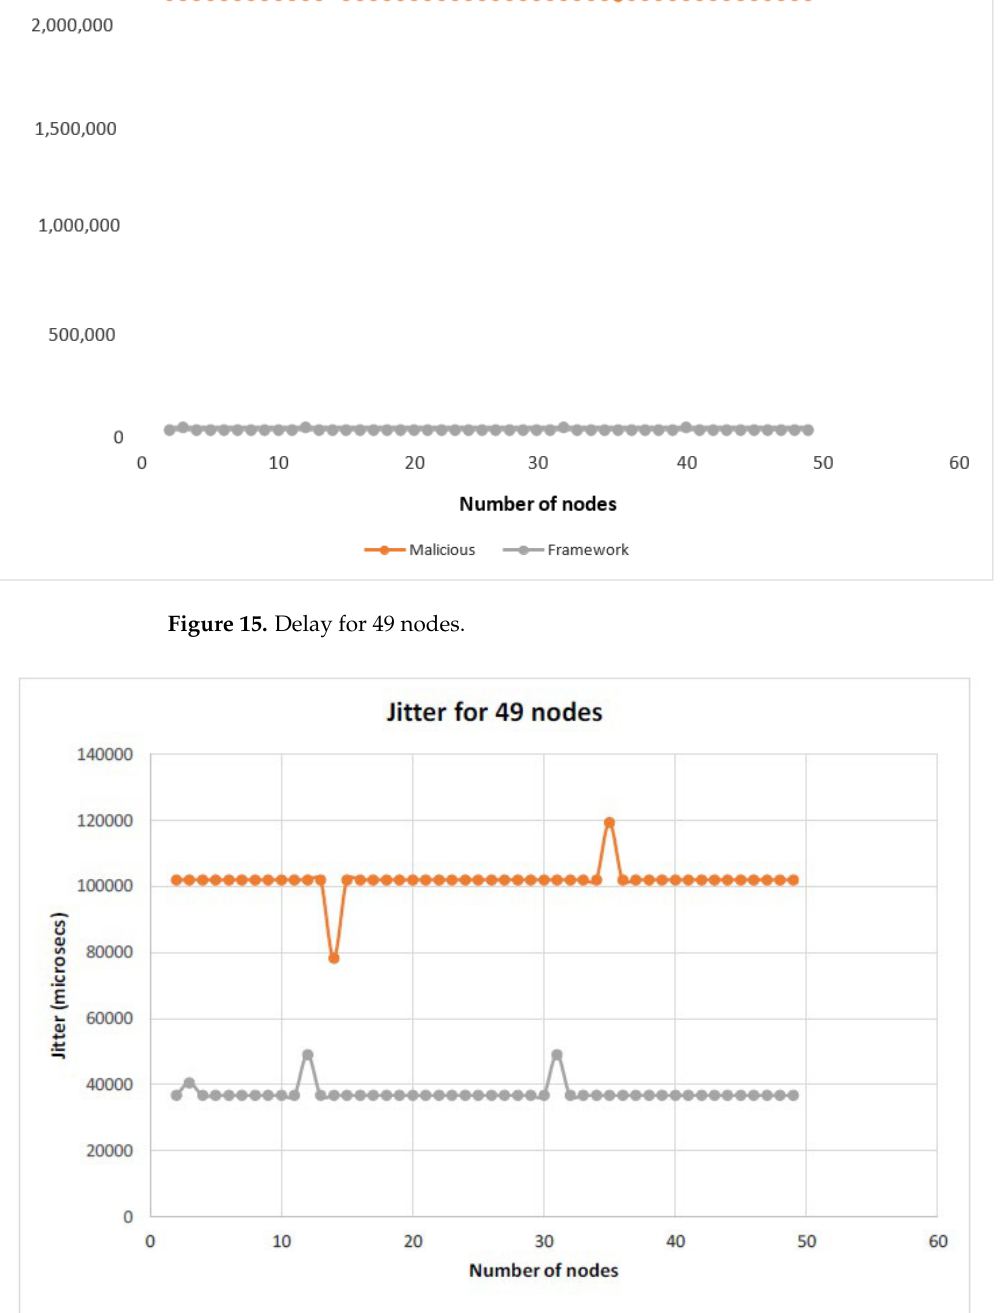
Figure 16. Jitter for 49 nodes.